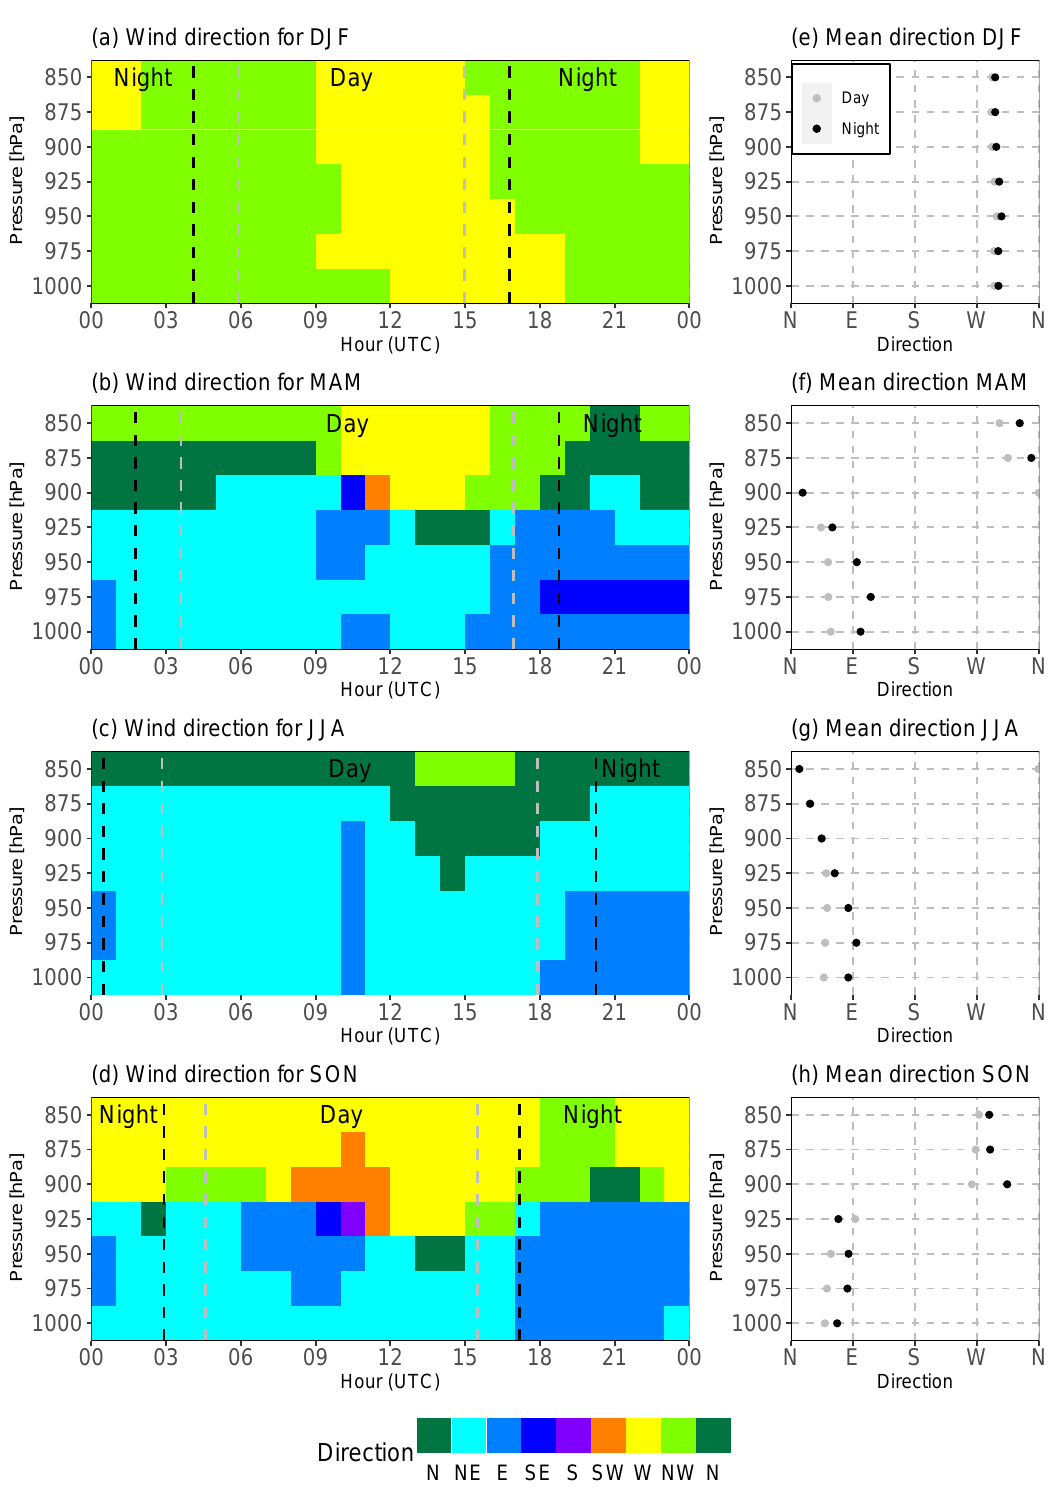
Figure 8. ERA5 hourly means of horizontal wind directions for 1990–2020 climatology period for all seasons ( a – b ) and the mean direction profiles for daytime and nighttime ( e – h ). The seasonal diurnal cycle of wind direction retrieved from ERA5 reanalysis shows a very good agreement with DWL measurements (Figure 9). Note that ERA5 reanalysis also show data at higher levels than those from DWL data. For example, during autumn, the data above 900 hPa are not shown in the DWL data. The comparison of the wind